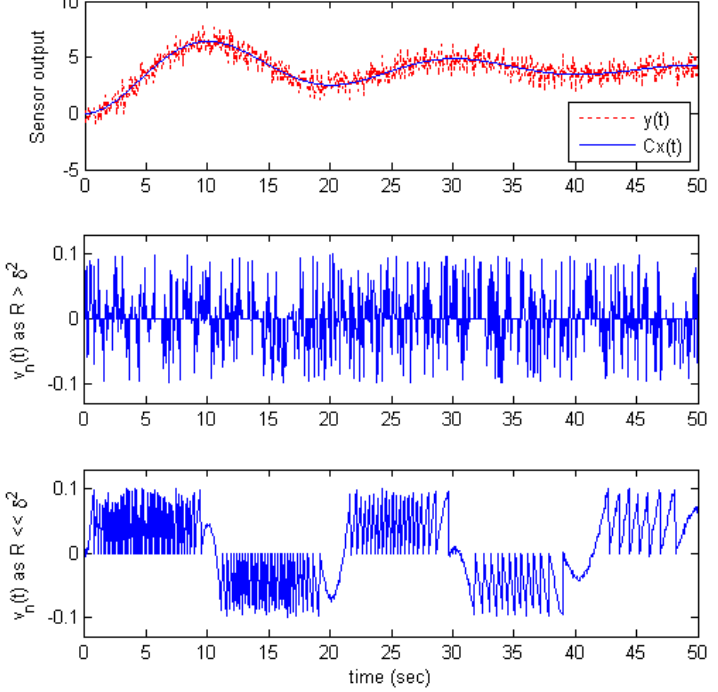
Figure 2. Effect of R and δ on measurement